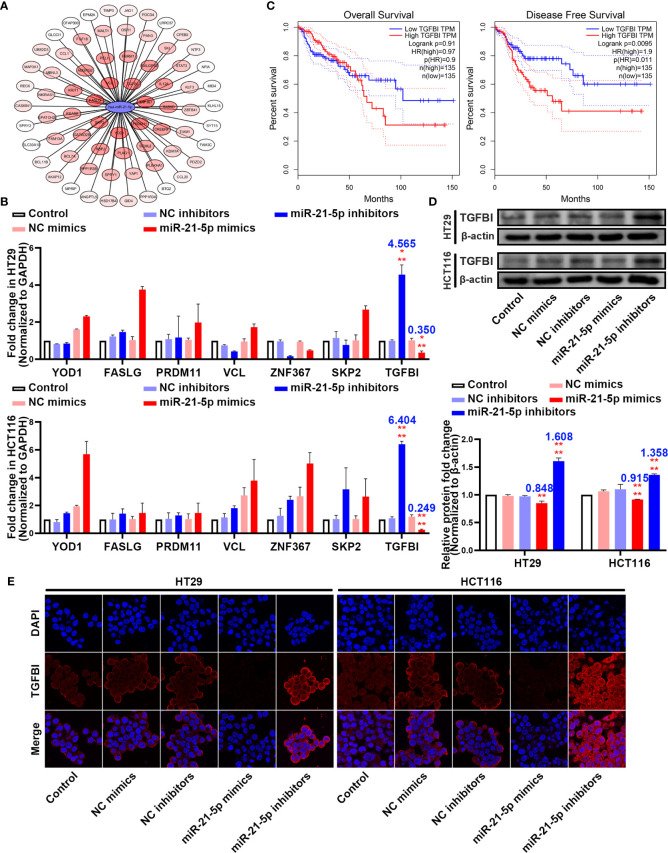
TGFBI is a potential target of miR-21-5p. (A) Bioinformatic prediction for candidate downstream targets of miR-21-5p. (B) Verification of miR-21-5p downstream targets by qRT-PCR in HT29 and HCT116. (C) Association of TGFBI expression with colorectal cancer (CRC) patient disease-free survival and overall survival. The areas between the same colour dotted lines represent 95% confidence interval for low/high TGFBI. (D) TGFBI expression in miR-21-5p mimics and inhibitors transfected HT29 and HCT116 cells as determined by western blot analysis. (E) Immunofluorescence staining of TGFBI expression in miR-21-5p mimics and inhibitors transfected HT29 and HCT116 cells. The bars and error bars indicate the mean ± SD. n.s.p > 0.05, **p < 0.01, ***p < 0.005, ****p < 0.001.